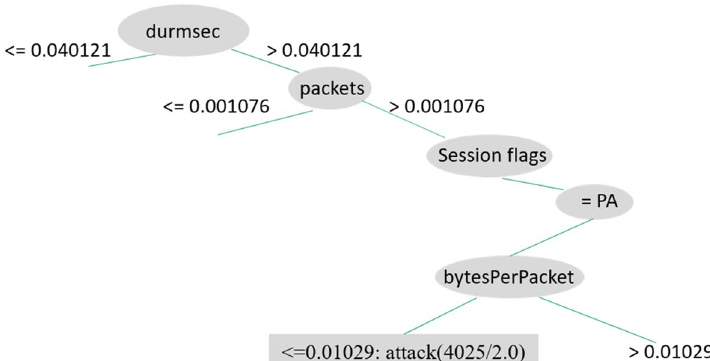
Fig. 7 C4.5D model tree